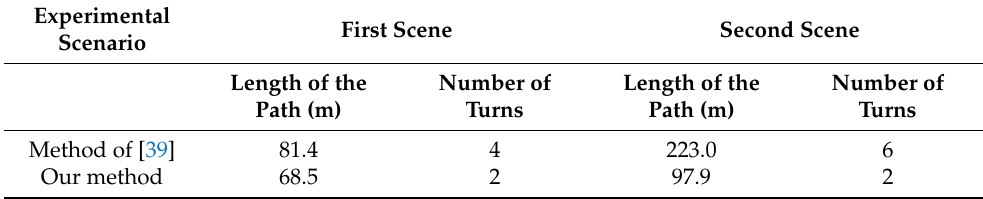
Figure 11. The output of the RatSLAM algorithm and the path planning results before and after the integration of the connectivity network of the first scene. ( a ) Output of the visual odometer. ( b ) Experience map of the first scene. ( c ) Path planning based on episodic memory. ( d ) The optimal path planned after introducing the connectivity network. Table 3. Comparisons of path planning.